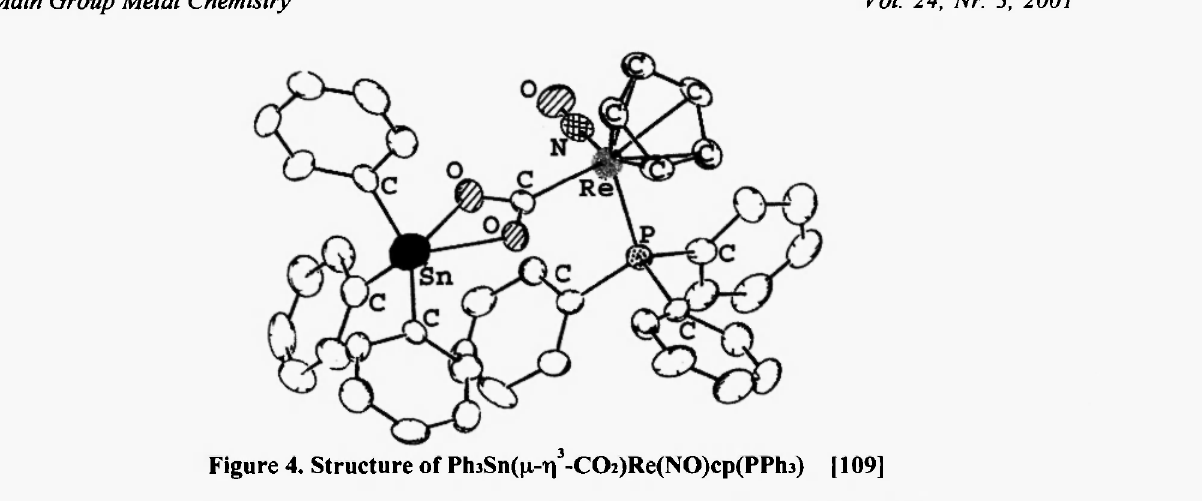
Figure 4. Structure of Ph 3 Sn^-Ti 3 -C02)Re(N0)cp(PPh 3 )